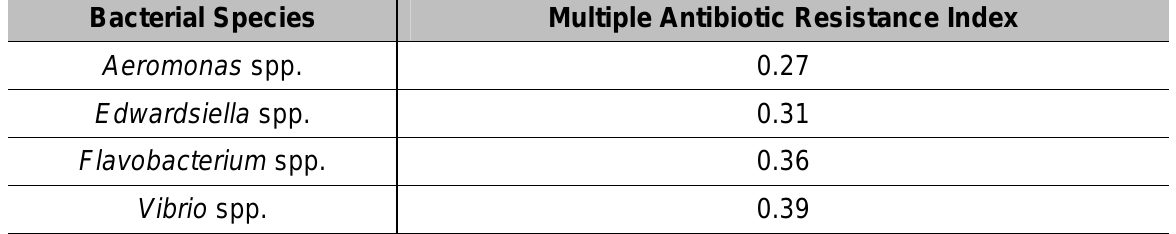
Table 2. MAR index of bacteria in the present study Bacterial Species Multiple Antibiotic Resistance Index Aeromonas